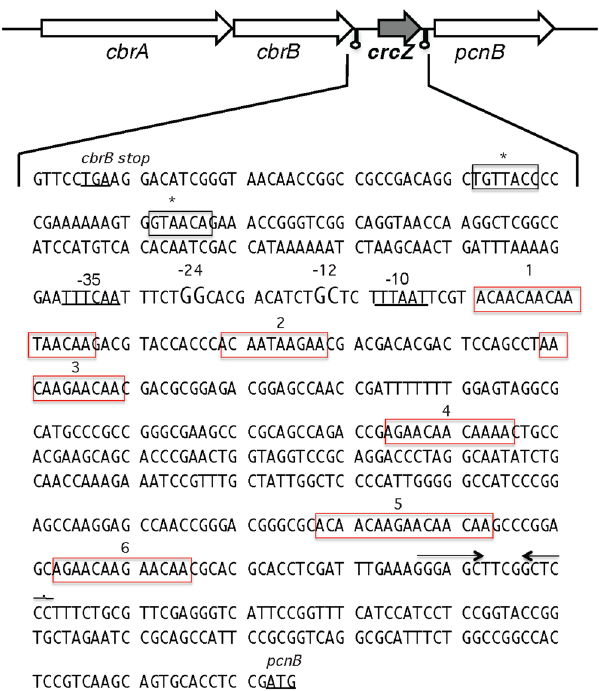
Figure 1. Genome context and nucleotide sequence of the A . vinelandii CrcZ sRNA. Terminators are indicated by small stem-loops. The six CrcZ A-rich Hfq-binding motifs are indicated by red boxes. The − 12 and − 24 regions of the predicted RpoN promoter and putative sequences recognized by CbrB (black boxes) are indicated. The predicted − 10 and − 35 regions of an RpoD promoter are underlined. Inverted repeats at the end of CrcZ are denoted by solid